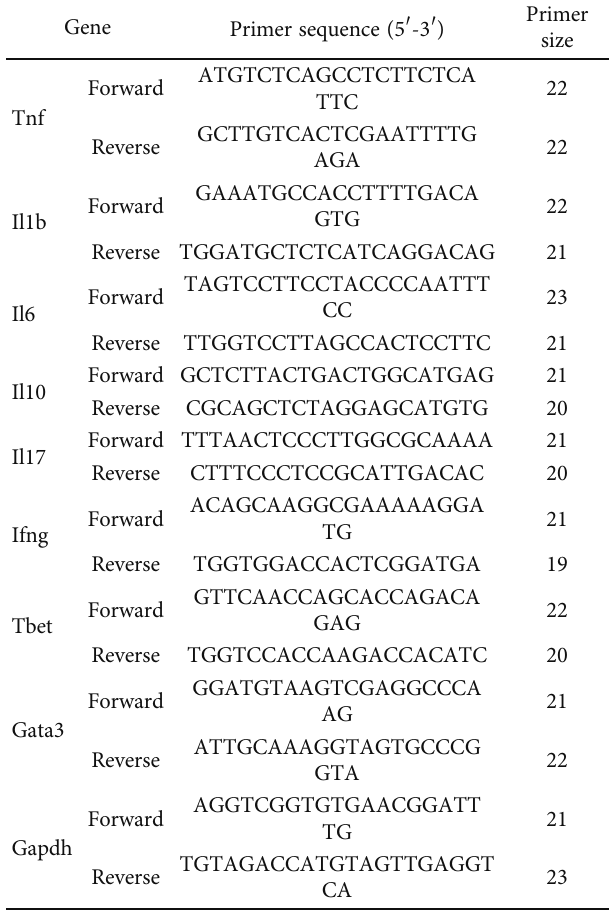
Table 1: Primer sequences used for RT-qPCR. Gene Primer sequence (5 ′ -3 ′ )